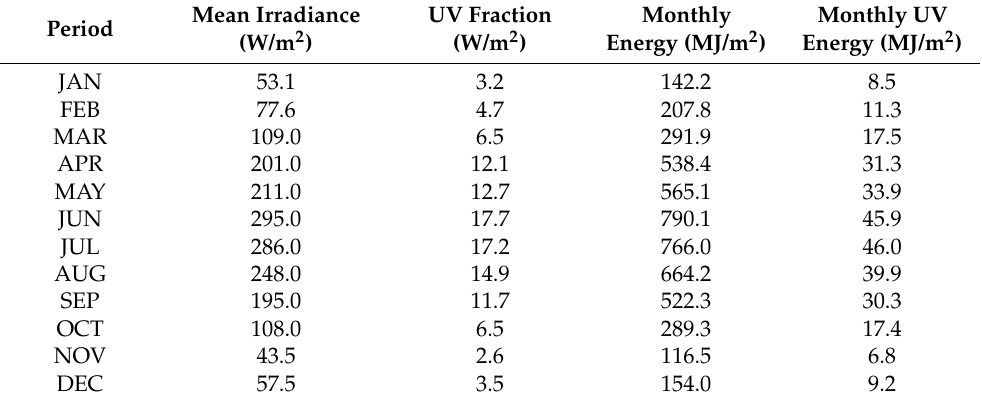
Table 1. Mean daily irradiance data, classified per month, measured by ARPA during 2018 for the city of Milan, Italy. Last two columns: total energy and UV energy monthly impinging on each m 2 of surface.